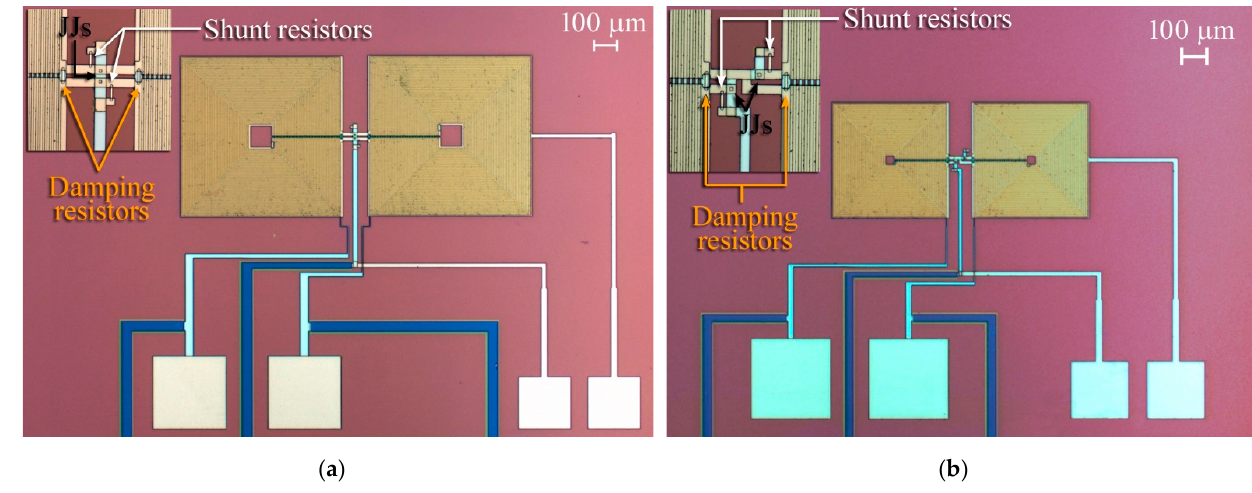
Figure 1. Picture of SQUID-based current gradiometric sensors. ( a ) Parallel configuration, ( b ) series configuration. In the respective insets, a magnification of area including Josephson junctions, damping and shunt resistors of both devices are shown and indicated by an arrow.